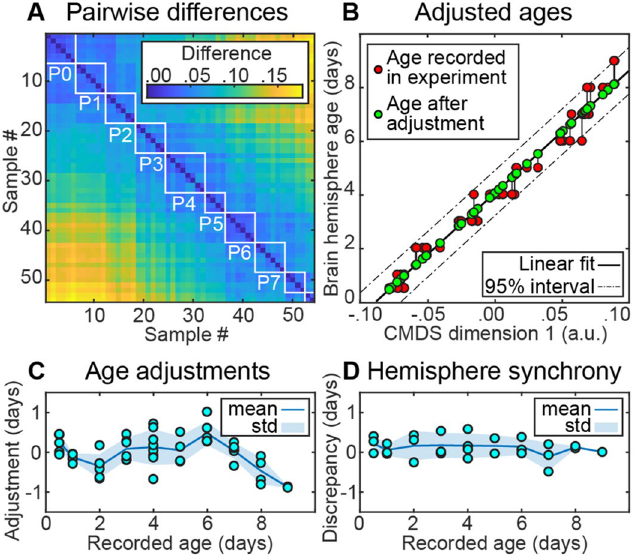
Figure 5. Temporal brain registration. We used differences between spatially registered brain samples to adjust the estimates of their developmental ages. ( A ) Pairwise differences (one minus Pearson correlation) between filtered 3D images of 54 hemispheres (of 27 brains). Boxes outline samples of the same ages as recorded in the experiment (P0; P1; P2 etc.). ( B ) Ages of brain samples as a function of the first CMDS component: the ages recorded in the experiment (red), linear fit (solid line) and the adjusted ages (green), 95% confidence interval (dashed line). ( C ) Age adjustment (difference between the adjusted and recorded ages) does not exceed one day. ( D ) Hemisphere synchrony (discrepancy between the adjusted ages of the left and right hemispheres in each